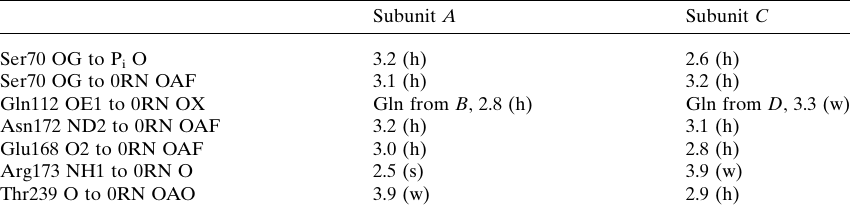
Table 4 Important distances in the active centers of BlaC. s, strong hydrogen bond up to 2.5 A˚ ; h, hydrogen bond from 2.6 to 3.2 A˚ ; w, weak interaction >3.2 A˚ (Jeffrey,